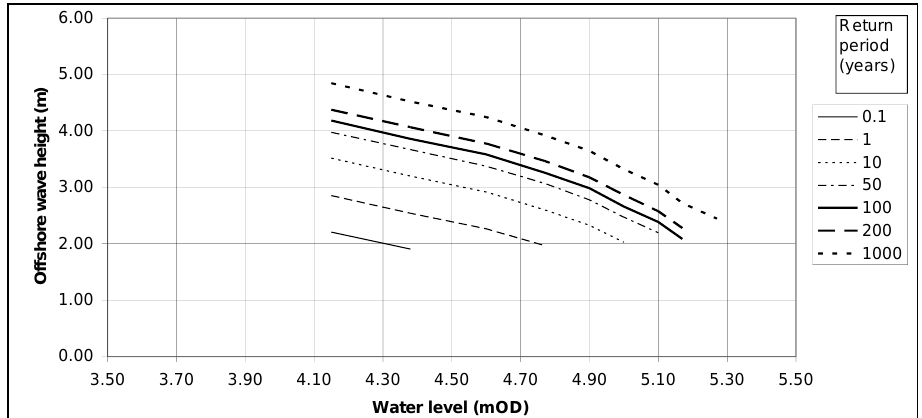
Figure 3. Joint Probability curves for 210° N, DEFRA 2107 future scenarios.